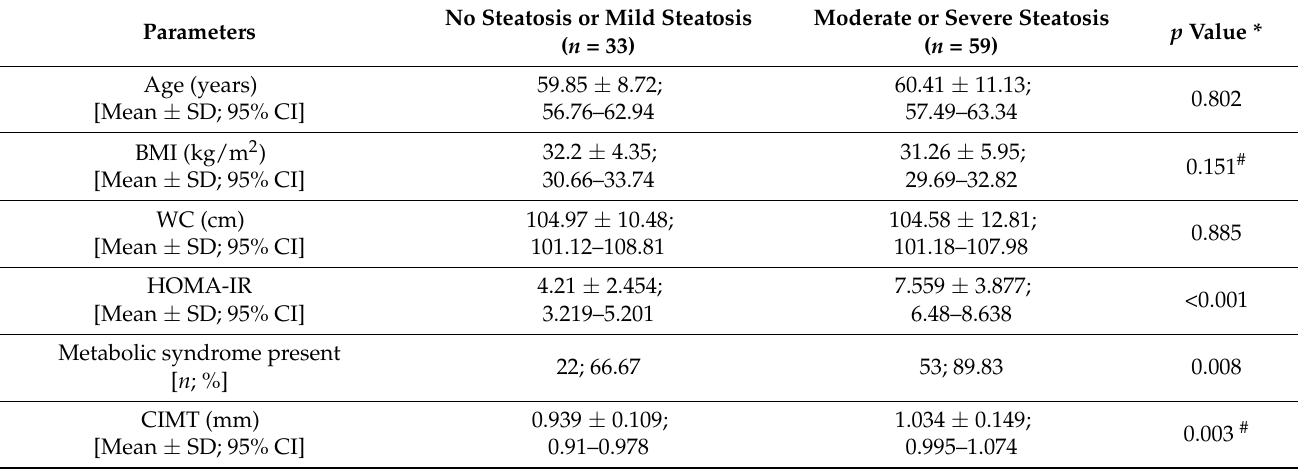
Table 2. Characteristics of the study population in relation to the presence of moderate or severe steatosis.